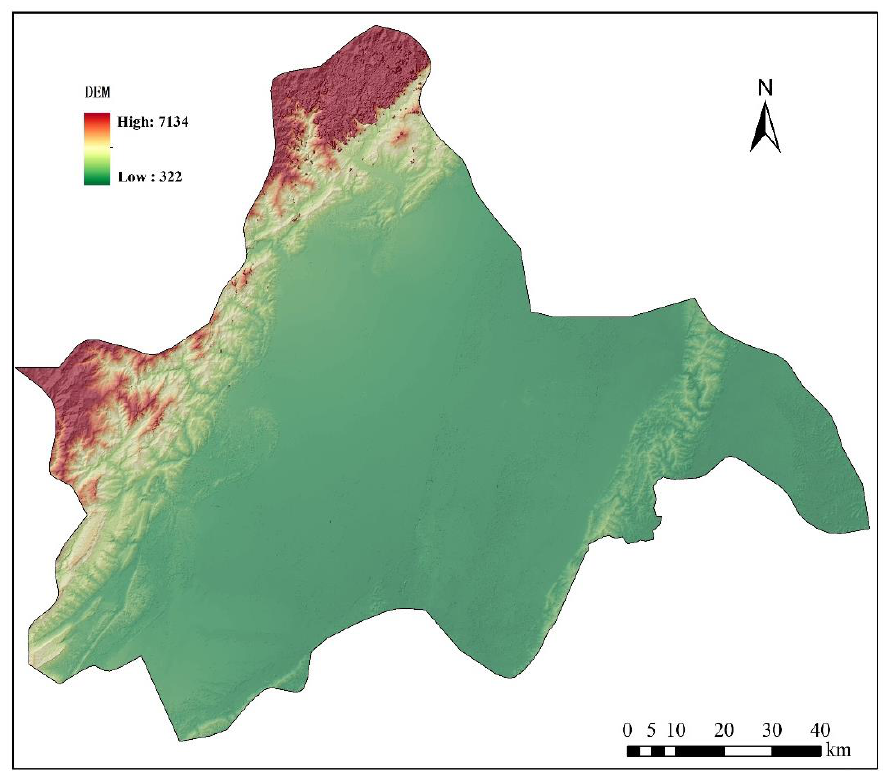
Figure 4. The elevation map of Chengdu. 3. Methodology